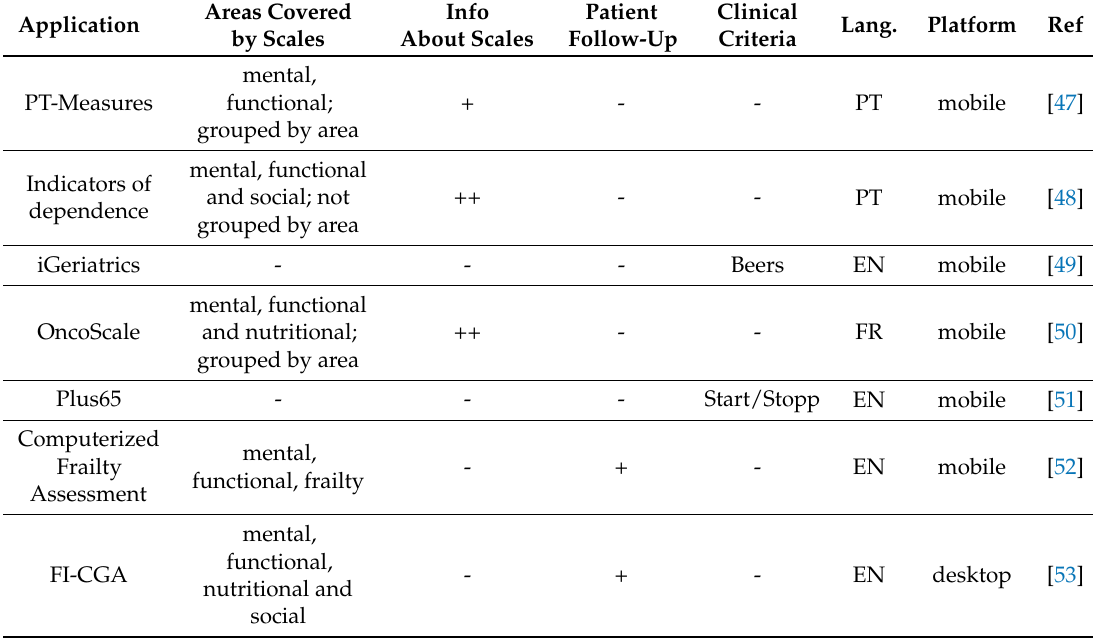
List of applications providing features related with geriatric assessment and their characteristics deemed relevant for the overall context of Comprehensive Geriatric